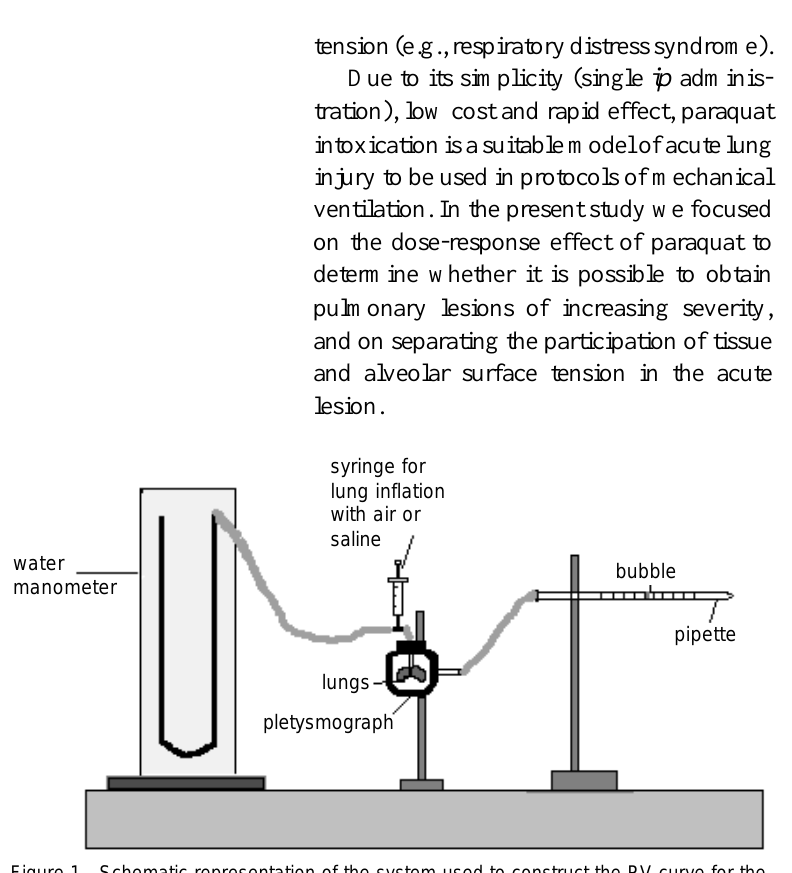
Figure 1 - Schematic representation of the system used to construct the PV curve for the excised rat lungs.